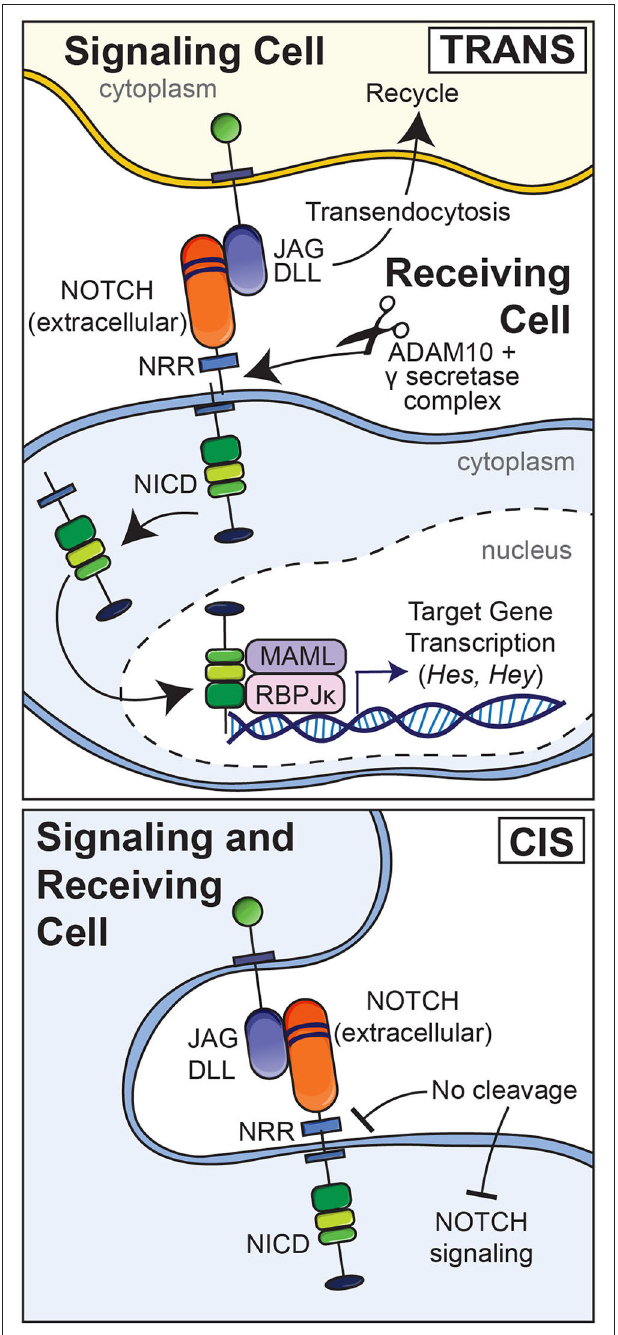
FIGURE 2 | Upper panel: Notch ligands (JAG and DLL) expressed by an adjacent signaling cell bind to epidermal growth factor (EGF) repeats 11 and 12 of Notch in a receiving cell ( trans ). This results in a pulling or hinge-like effect that exposes the heterodimerization domain of Notch to the actions of the metalloprotease disintegrin and metalloprotease domain (ADAM) 10 and the γ -secretase complex. The ligand is internalized by endocytosis and recycled whereas Notch releases its intracellular domain (NICD) to the cytoplasm. The NICD translocates to the nucleus to form a complex with RBPJ κ and Mastermind (MAML), and recruits co-activators to induce the transcription of target genes. Lower panel: Interactions between a Notch ligand and Notch expressed by the same cell ( cis ) result in an inhibition of Notch